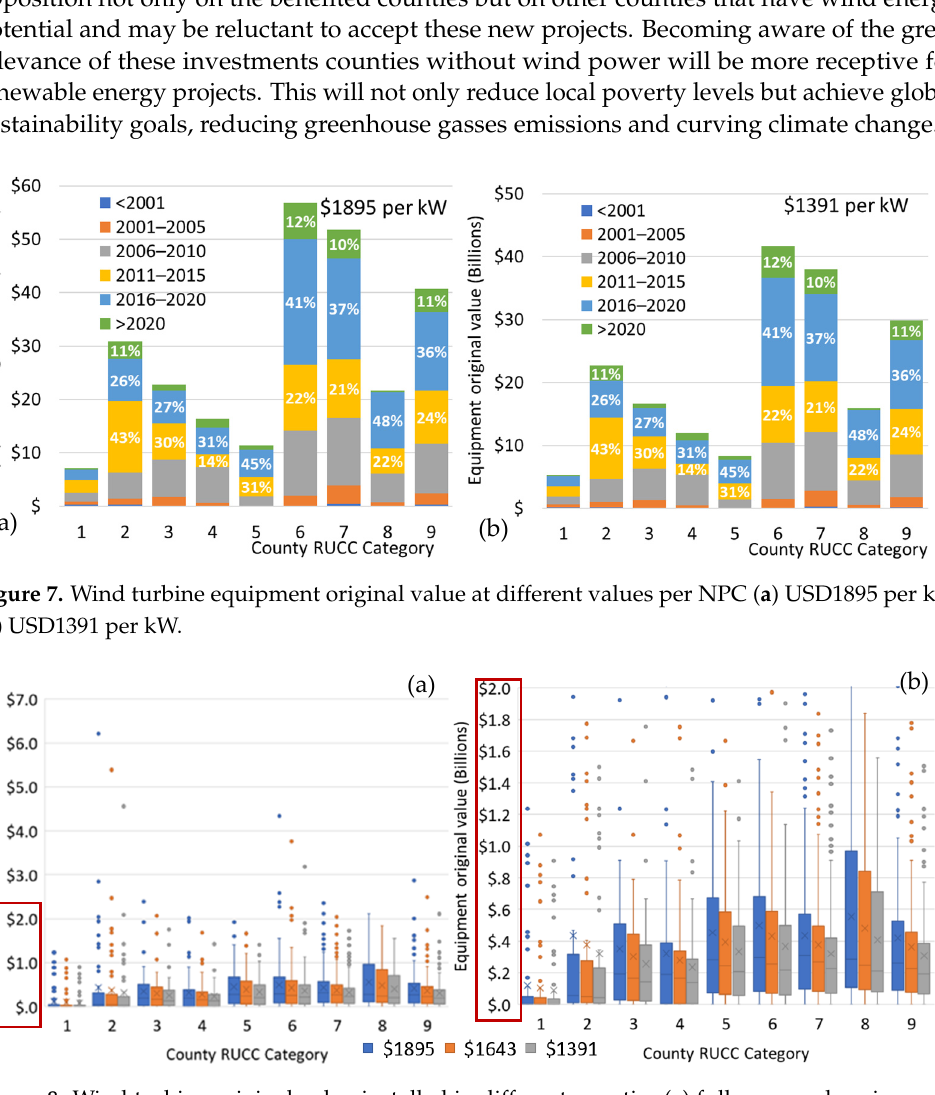
Figure 8. Wind turbine original value installed in different counties ( a ) full range values in y -axis ( b ) limited range values in y -axis to enhance data visibility.